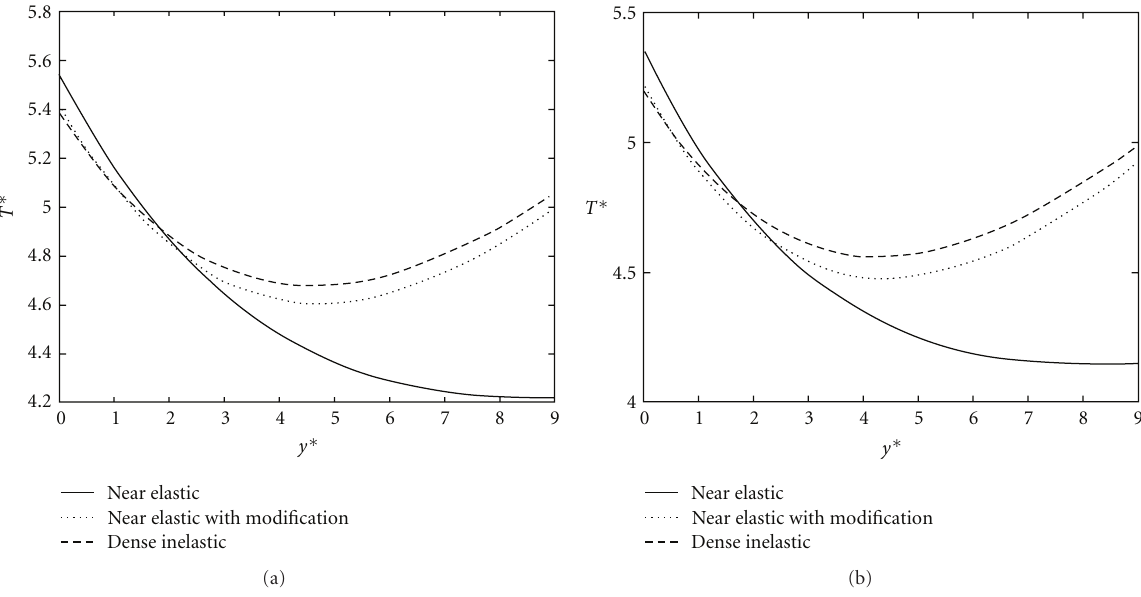
Figure 7: (a) Comparison of granular temperature variation along y direction at right hand side of two-dimensional cell for (i) near elastic model, (ii) near elastic model with modification, and (iii) dense inelastic model for V ∗ = 3 . 0. (b) Comparison of granular temperature variation along y direction at left hand side of two-dimensional cell for (i) near elastic model (ii) near elastic model with modification, and (iii) dense inelastic model for V ∗ = 3 . 0.